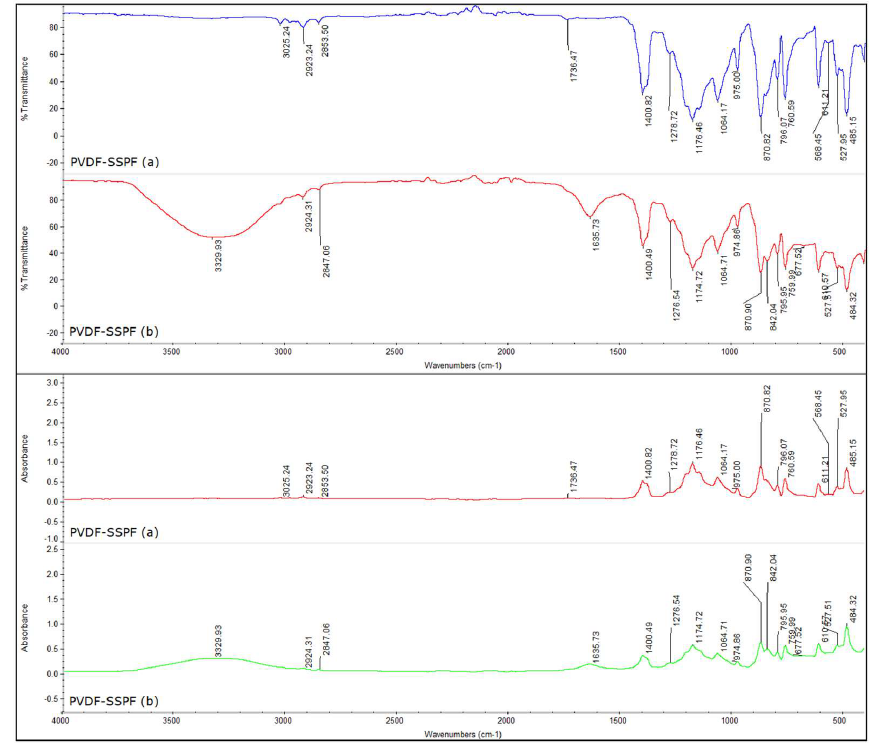
Figure 1. FTIR spectra of the PVDF–SSPF composites with wavenumber ranges from 4000 cm − 1 to 500 cm − 1 , ( a ) non-immersed specimens, ( b ) immersed